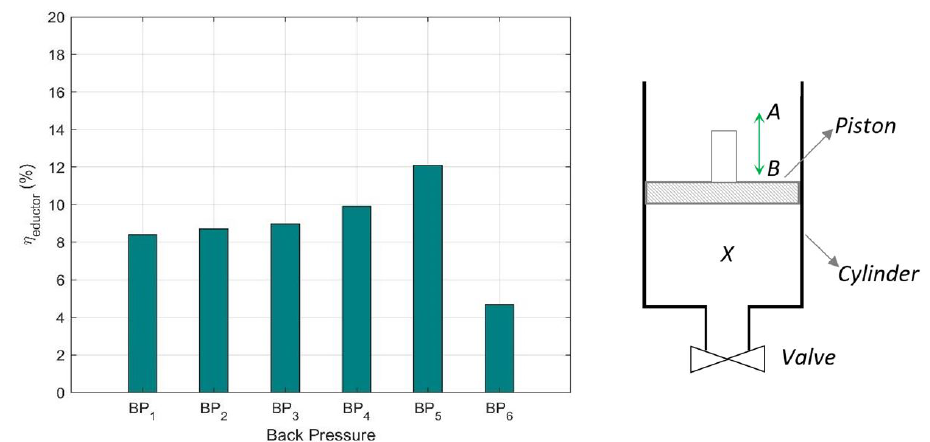
Figure 16. Efficiency of Eductor at different back